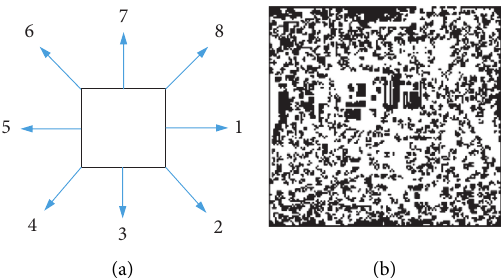
Figure 1: 2D model of asphalt pavement based on QSGS method. (a) Random growth in different directions. (b) 2D model with random pore distribution.